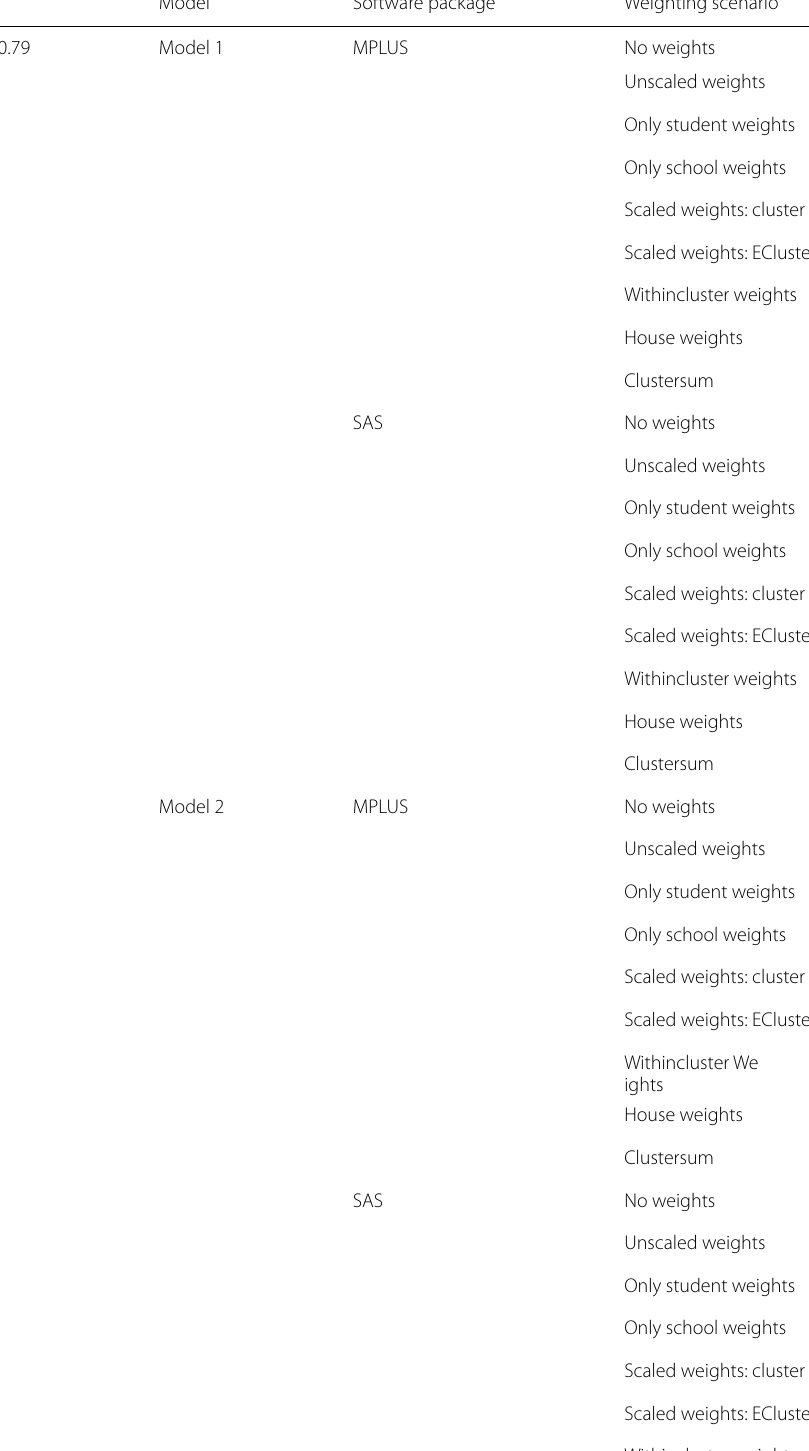
Table 3 Simulation scenarios including varying ICCs, three investigated hierarchical models and different weighting approaches combined with different estimation algorithms implemented in the two examined software